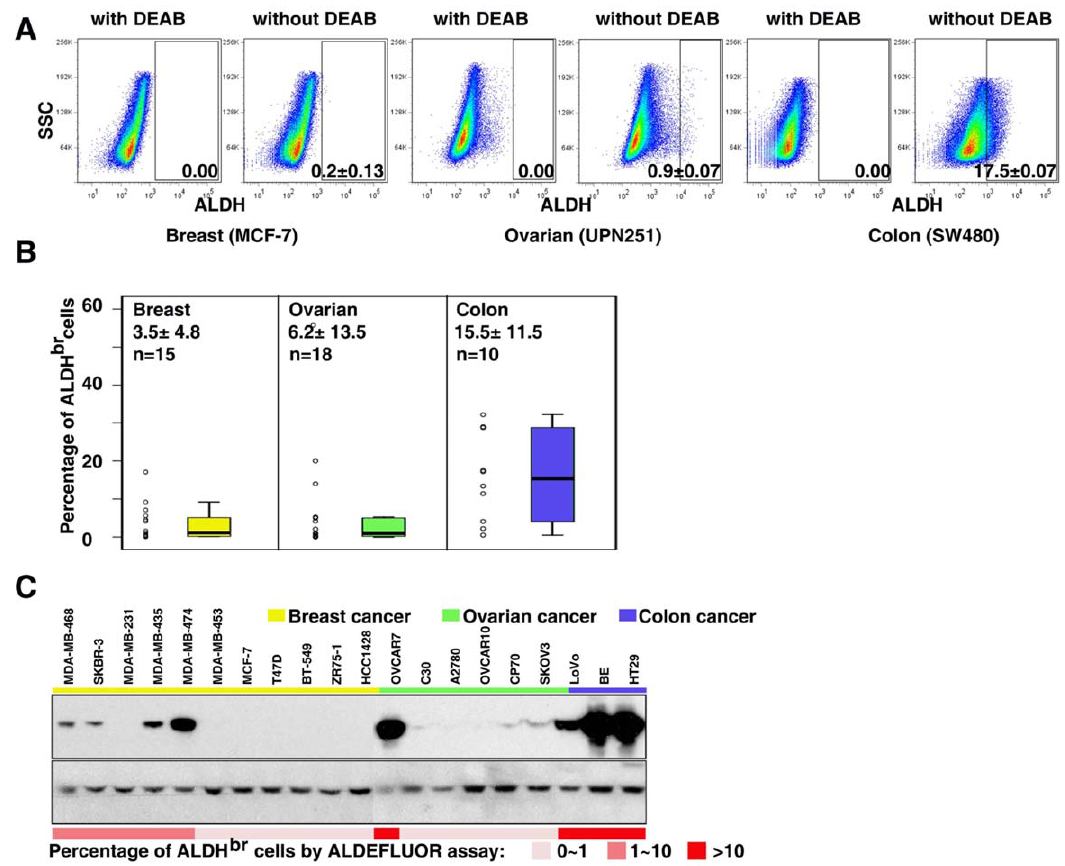
Figure 3. ALDH1 enzymatic activity and expression in established epithelial tumor cell lines. A . ALDH1 enzymatic activity was detected using the ALDEFLUOR assay. DEAB was used to inhibit the reaction of ALDH with the ALDEFLUOR reagent, providing a negative control. B . Summary of ALDH1 enzymatic activity in established breast (n=15), ovarian (n=18) and colon (n=10) cancer cell lines. C . ALDH1 protein expression was detected by western blots. There was a positive correlation between ALDH1 protein expression and ALDH1 enzymatic activity. Full-length blots are presented in Supplemental Figure S3.